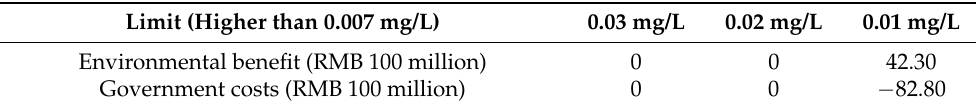
Table 11. Environmental benefit and government costs due to the limit change.